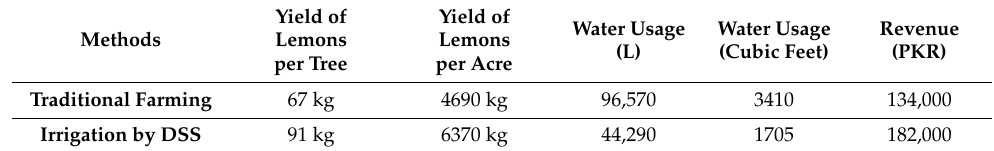
Table 3. Yield increase for lemon crop.